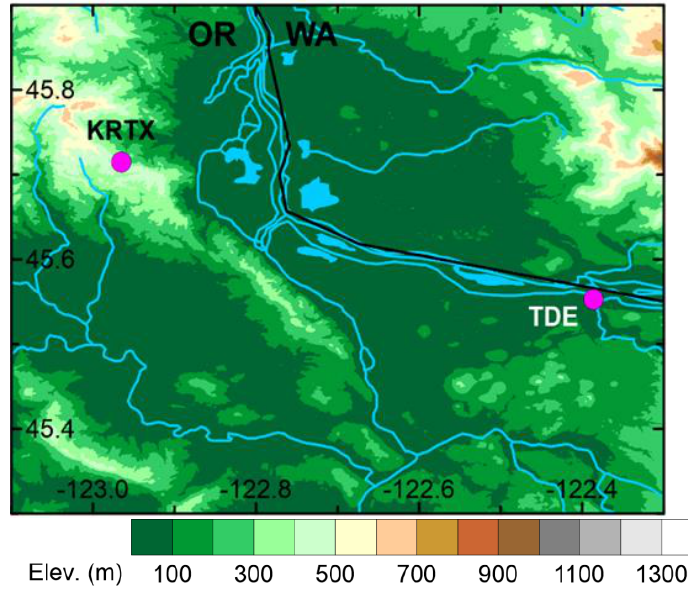
Figure 1. A map showing locations of the KRTX radar and the Troutdale (TDE) sites (courtesy of Dr. A.B. White, National Oceanic and Atmospheric Administration (NOAA) Physical Sciences Laboratory).